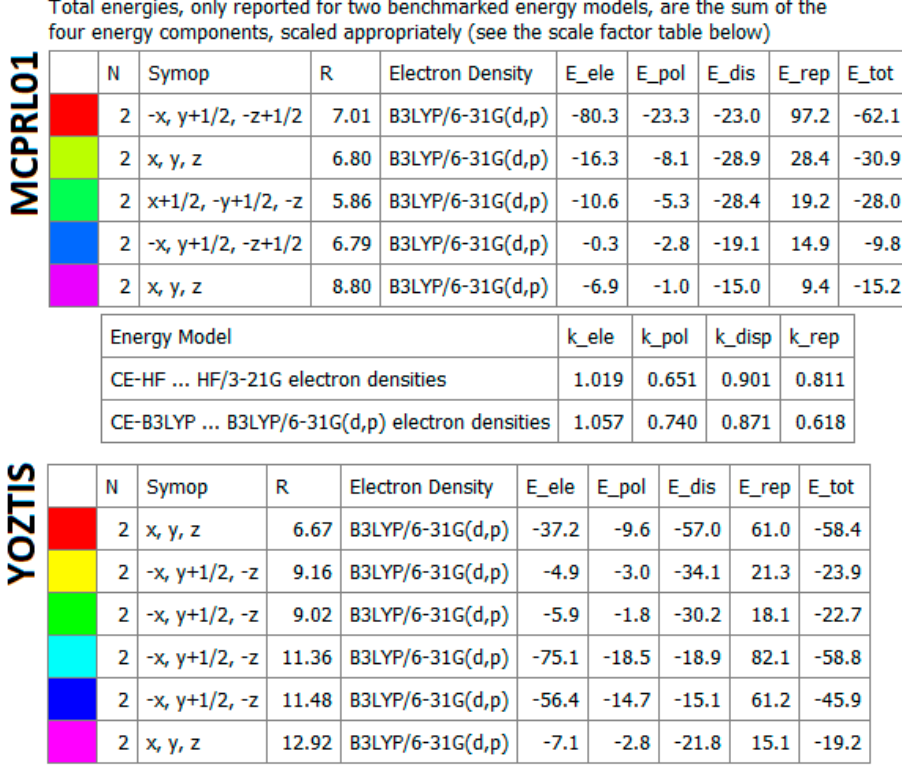
Figure 21. Energy frameworks of diketopiperazine perindopril structures corresponding to the electrostatic and dispersion energy components, and total energy framework along the a, b and c -axis (the tube size: 300).